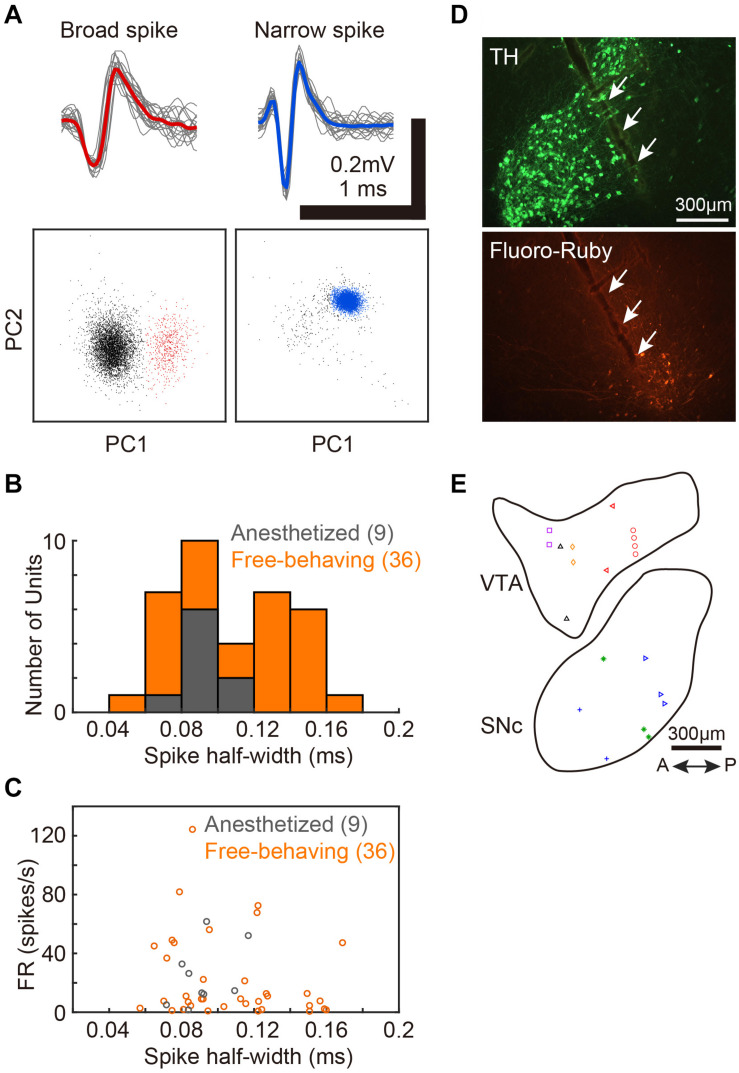
Single-unit recordings from VTA/SNc and the positions of recording sites. (A) Two distinct spike waveforms (top) and the spike clusters (bottom) from 2 single-units in VTA. Broad spike (red, left) and narrow spike (blue, right) units. Red and blue lines represent mean spike waveform of each single-unit. The gray lines represent the single spikes (20 spike waveforms). In the bottom panels, colored dots (red and blue) indicate extracted spikes as a single-unit. Gray dots indicate noise cluster. (B) Distributions of spike half-width of all single-units recoded from anesthetized (gray histogram, 9 units, 2 birds) and free-behaving (orange histogram, 36 units, 6 birds) conditions. (C) Spontaneous firing rates of each VTA/SNc unit during awake state is plotted against the spike half-width. Gray and orange circles denote single-unit data from anesthetized and free-behaving conditions, respectively. (D) Histological verification of electrophysiological recording sites. Tyrosine hydroxylase (TH) immunostaining (top) and injection sites of Fluoro-Ruby (bottom). White arrows indicate the track of the recording electrode in SNc. (E) Recording sites from all birds (2 anesthetized and 6 free-behaving conditions) are displayed in the example sagittal sections. Same symbols (color/shape) denote recordings from the same bird. Multiple single-units (2–6 units) were simultaneously recorded at 10 out of the 20 recording sites.